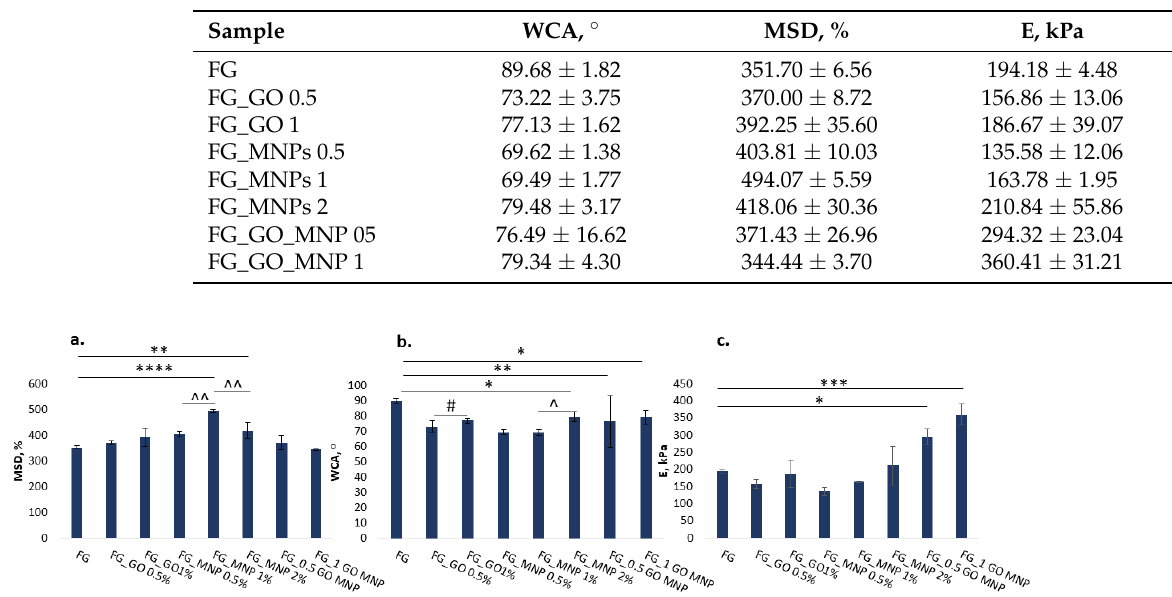
Figure 4. ( a ) Maximum swelling degree determined in PBS at 37 °C; ( b ) water contact angle; ( c ) tensile Young’s modulus at 5% deformation. Statistical significance: different symbols were used to show the statistical difference between different categories of samples- “*” was used to show comparison between the composites and the FG control; “#” was used for comparisons between samples with GO content; “^” was used for statistical comparisons between samples with MNP content; *, #, ^ p < 0.05, **, ^^ p < 0.01, *** p < 0.001, **** p < 0.0001.